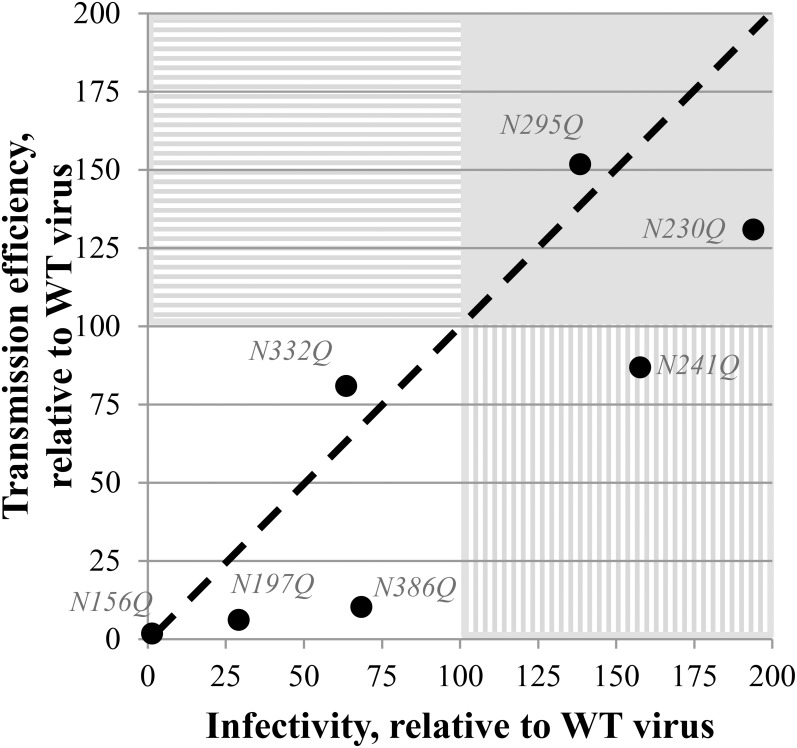
Correlation between the infectivity and transmission efficiency of the gp120 N-glycan deleted mutant virus strains, relative to WT virus.The black dashed line represents a curve where infectivity and transmission would have been equally influenced by the mutations. White quadrant: both transmission and infectivity are decreased. Full grey quadrant: both transmission and infectivity are increased. Quadrant with horizontal striping: transmission efficiency is increased while infectivity is decreased. Quadrant with vertical striping: infectivity is increased while transmission efficiency is decreased.